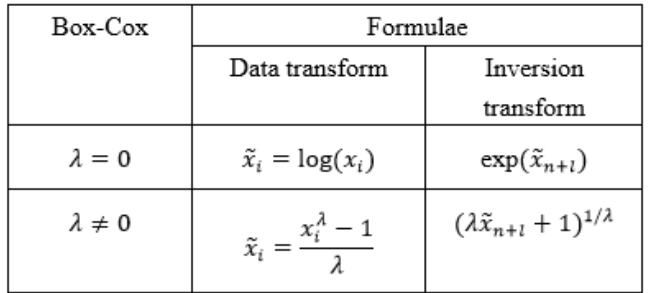
Table 2. Box-Cox power transform